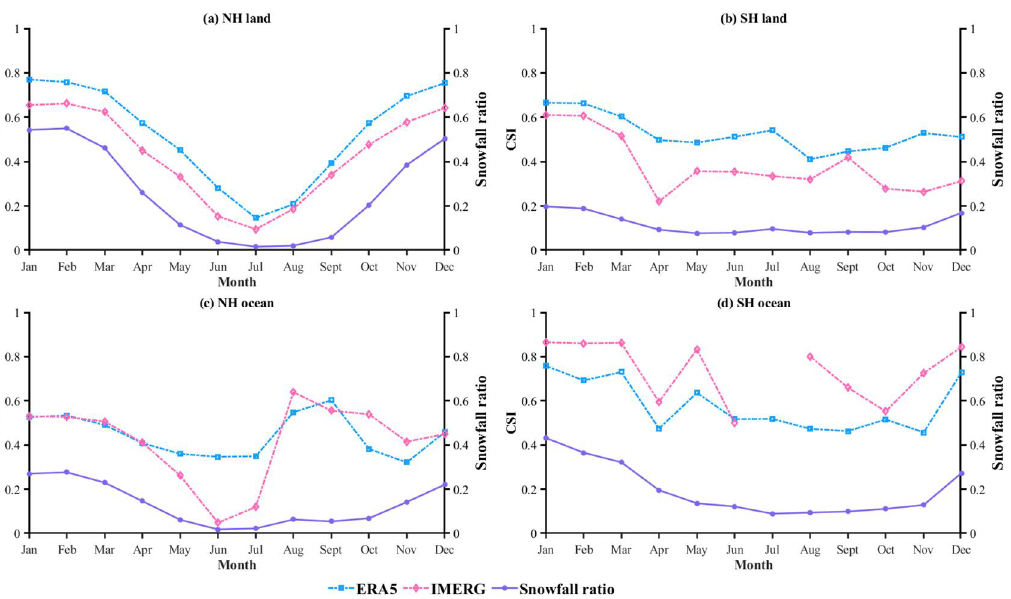
Figure 5. Plots of mean snowfall ratio and CSI of ERA5 and IMERG products during different months. The subplots ( a , c ) refer to the CSI metric for IMERG over NH land and NH ocean. The subplots ( b , d ) refer to the CSI metric for ERA5 over SH land and SH ocean.